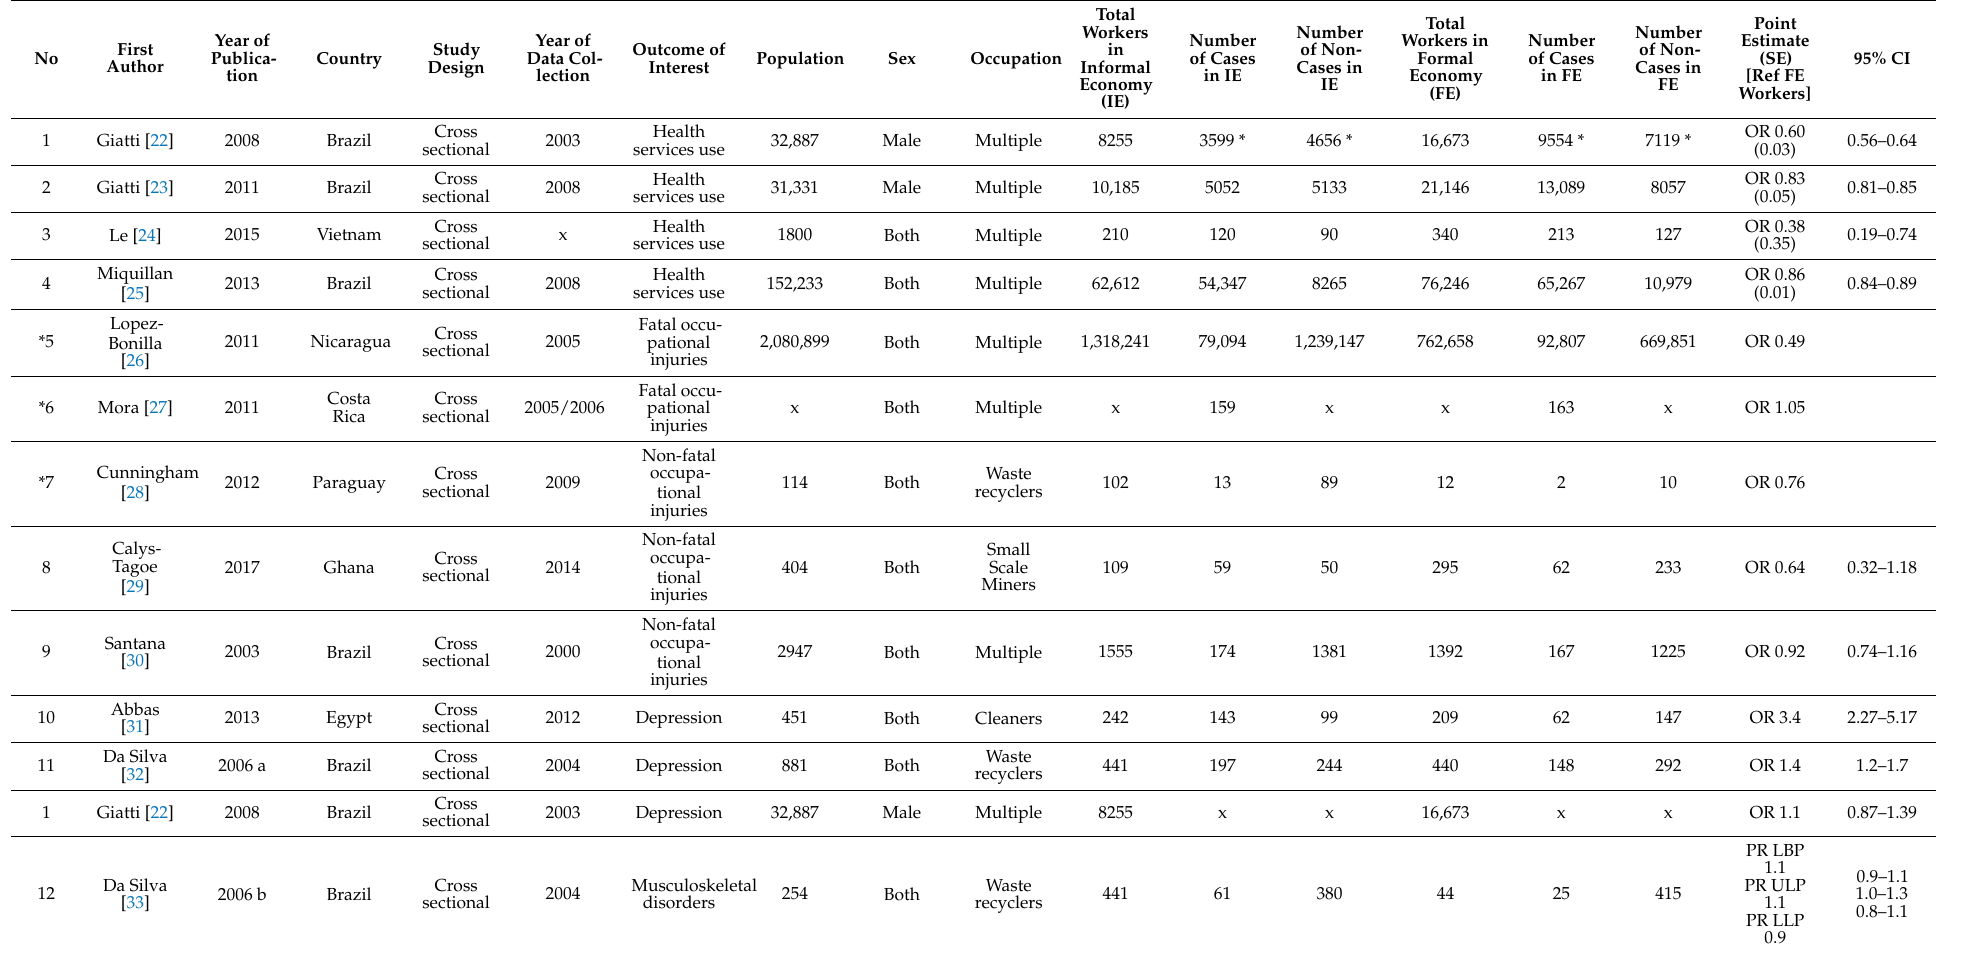
Table 2. Characteristics of the 12 studies included in the systematic